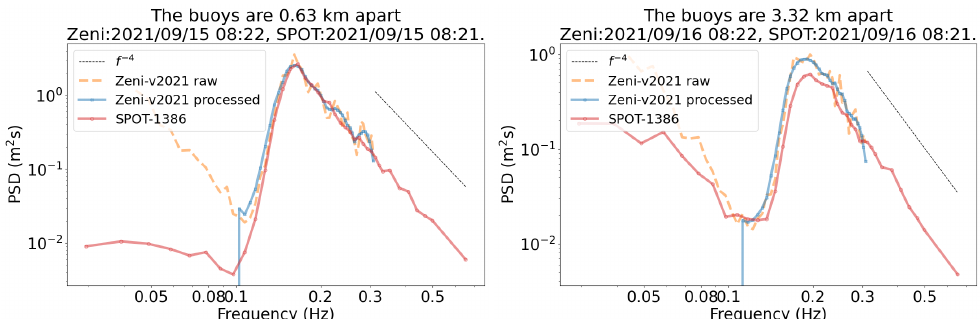
Figure 7. Comparison of Zeni-v2021 and SPOT-1386 spectra at 08:21 15 September 2021 ( left ) and 08:21 16 September 2021 ( right ): the distances between the buoys were roughly 1 km and 3 km, respectively. Low-frequency noise of Zeni-v2021 spectra was removed by applying an ideal filter at the lowest frequency local minimum of the smoothed spectrum, similar to what was reported in Waseda et al. [63], Nose et al. [64], which is a common postprocessing step when working with accelerometer-derived wave data. This indicates agreement within typically 5% between the Sofar Spotter and the instrument v2021 measurements in the open water, before the instruments drift away from each